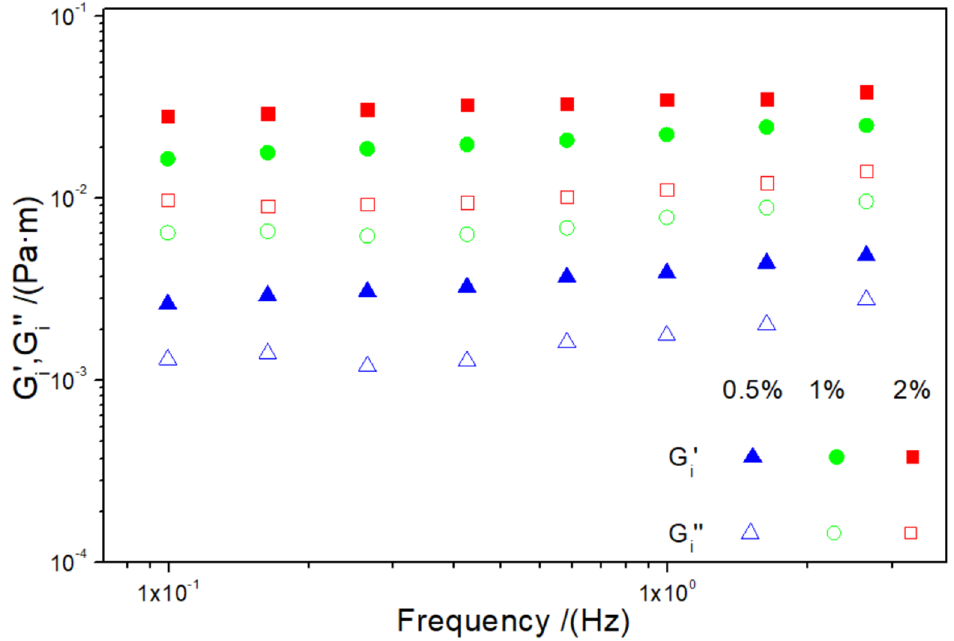
Figure 3. Elastic (G ′ i ) and viscous (G ″ i ) moduli as function of frequency for the three systems tested at pH 2.